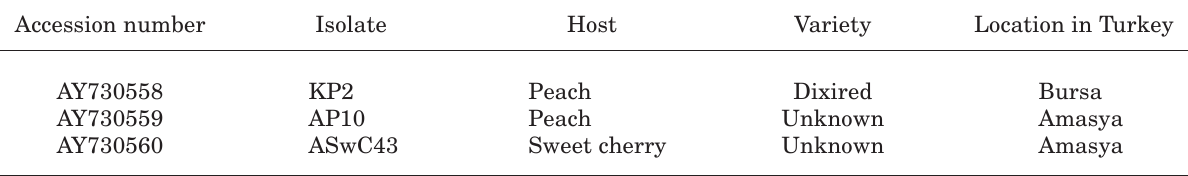
Table 1. Description of Turkish Apple chlorotic leaf spot virus